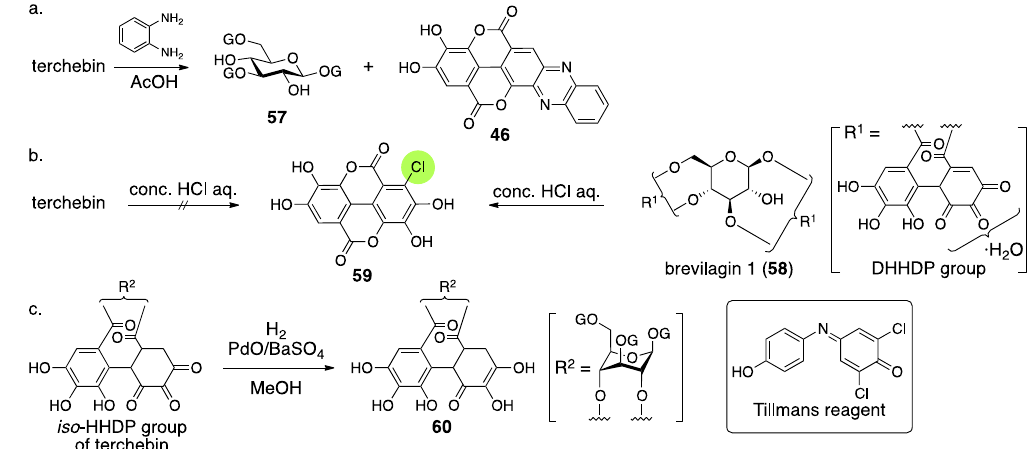
Figure 24. The transformations used for the determination of the first structure of terchebin ( 54 ).